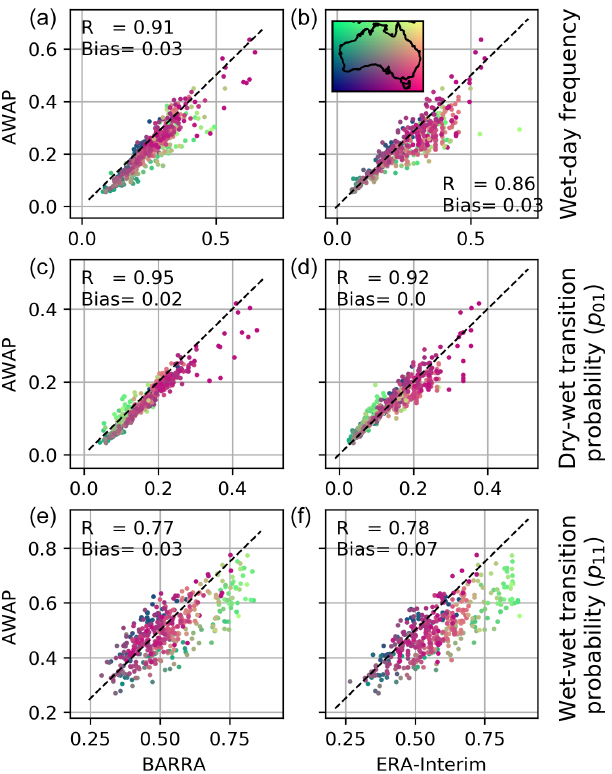
Figure 9. Quantile estimates (mmd − 1 ; 90%, 95% and 99%, in a– b , c–d , and e–f , respectively) from reanalysis datasets (BARRA and ERA-Interim) and AWAP at gauge locations. The colour of the scat- ter indicates the location of the AWAP